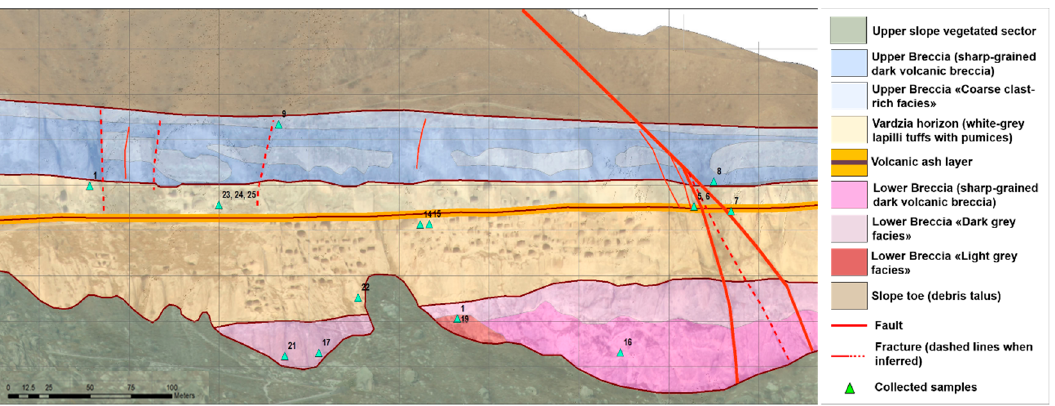
Figure 5. 3D geological map of Vardzia slope (obtained with Unmanned Aerial Vehicle (UAV)-based Digital Photogrammetry (DP) 3D surface).